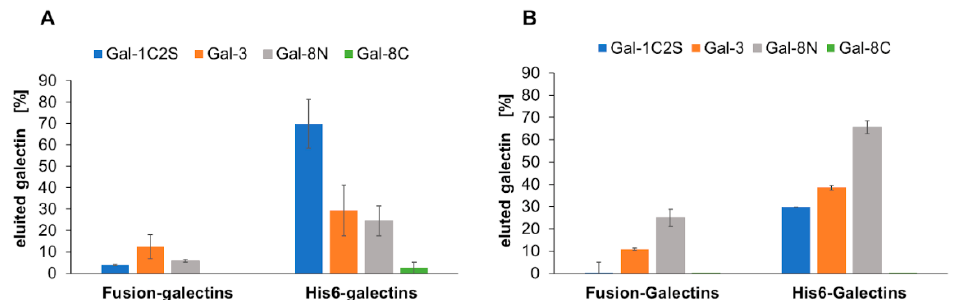
Figure 1. Analysis of purification for galectin fusion proteins (His 6 -SNAP-Fluorescent protein- Galectin) and His 6 -Galectins. ( A ) ASF affinity resin; ( B ) Fetuin affinity resin. 0.2 µ moL of each galectin IMAC eluate was applied to the column and eluted with PBS pH 7.5 + 300 mM lactose in a gradient mode. The amount of eluted galectin was determined by Bradford assay with bovine serum albumin as a reference. The purifications were repeated three times for each